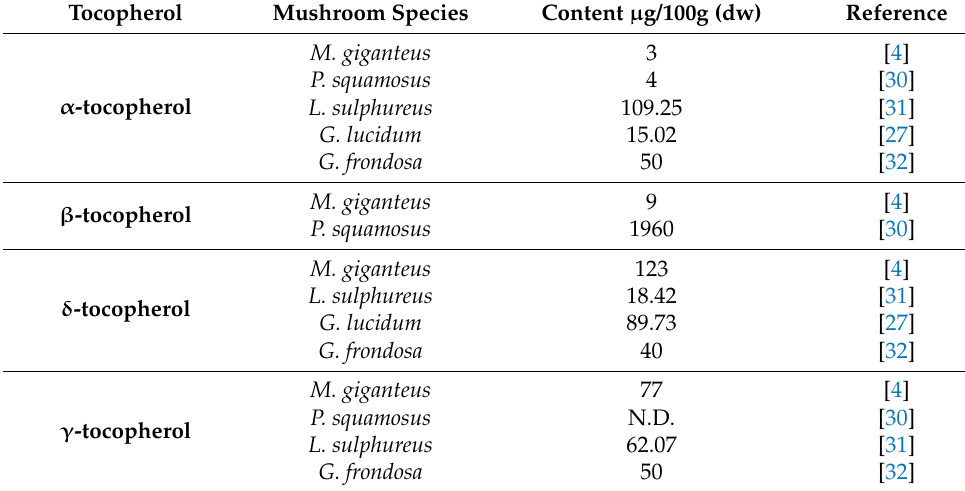
Table 1. Composition of tocopherols in Polyporales